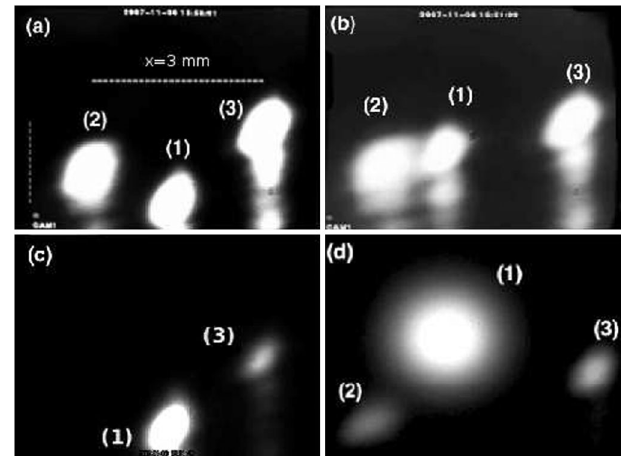
FIG. 1. Different configurations of the three beams stored in the SOLEIL storage ring in November 2007. The four images are obtained using the visible part of a dipole based photon beam for different settings of rf frequency (b) and sextupole magnet strengths [(c), (d)]. Figure axes are vertical and horizontal beam positions. The strong vertical trails of the beams are artifacts of the measurement and result from the mirror quality of the visible light monitor which was damaged after an irre- versible thermal